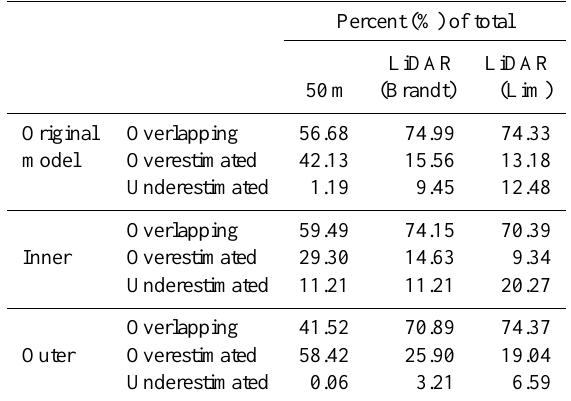
Table 2. Results of feature agreement statistics for the different modelling results derived from DEMs having different data reso- lution, and as produced by different modellers, compared with the flood of